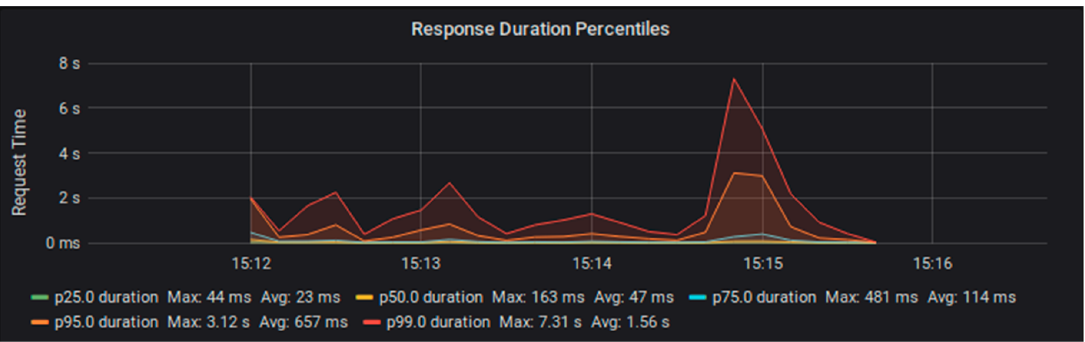
Figure 8. Trellis Cassandra (four and four) system performs at 480 requests per second.